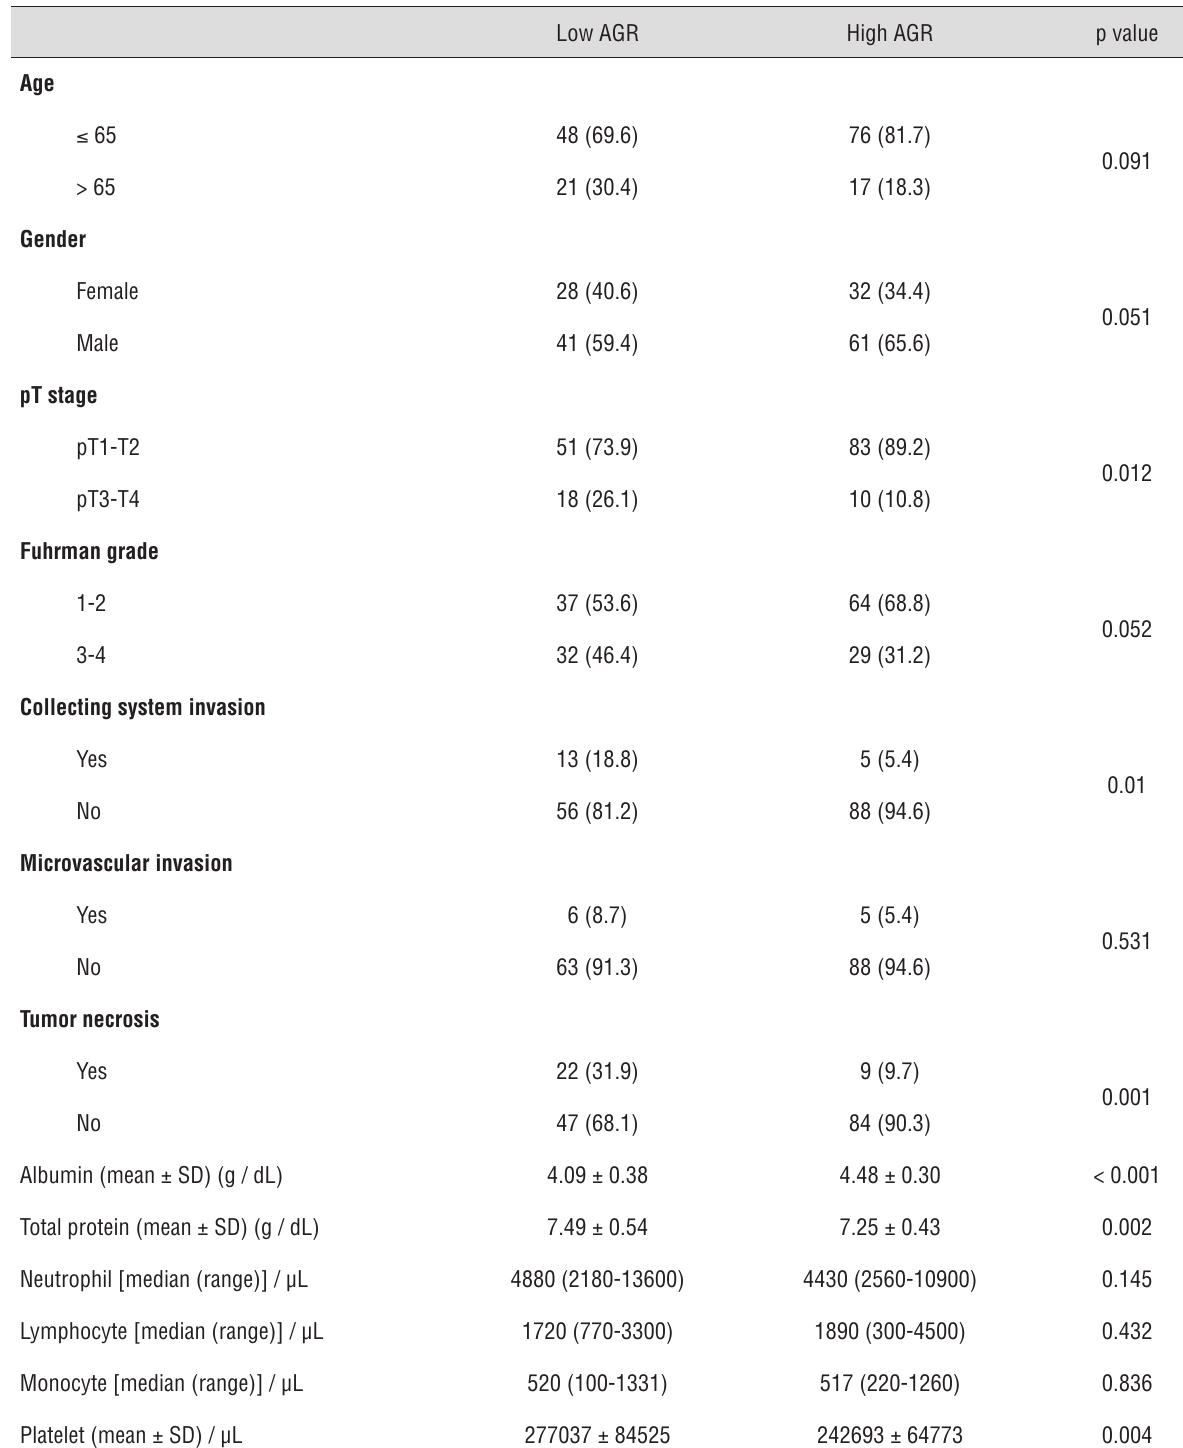
Table 2 - Associations between AGR and clinicopathological